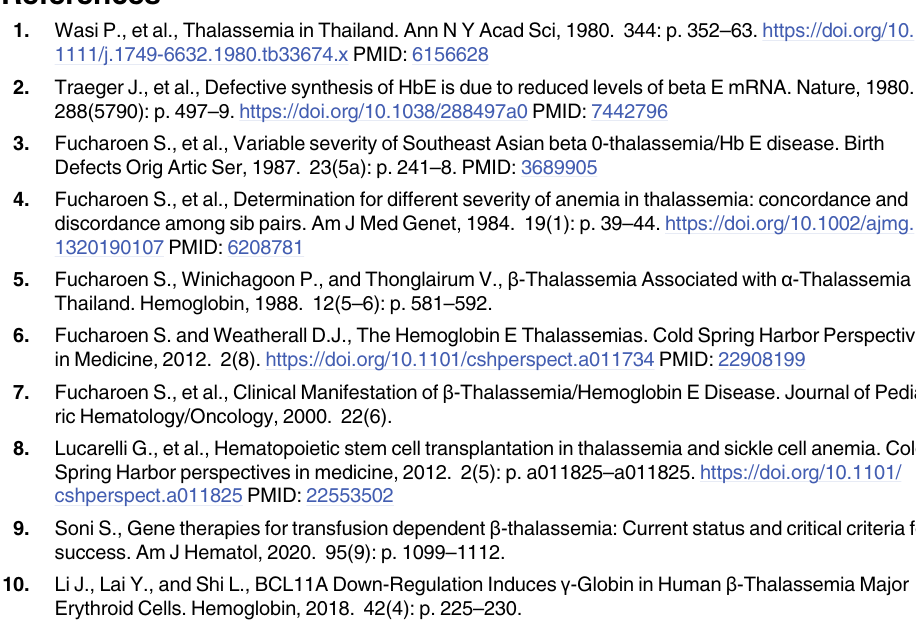
S2 Table. List of primer sequences used for qPCR in this